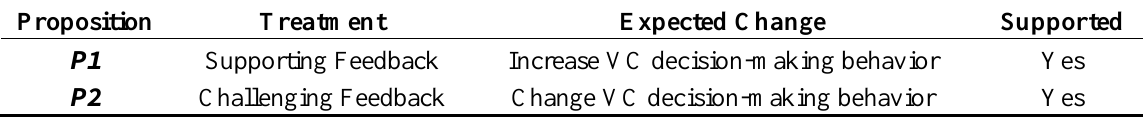
Table 9. Expected Feedback